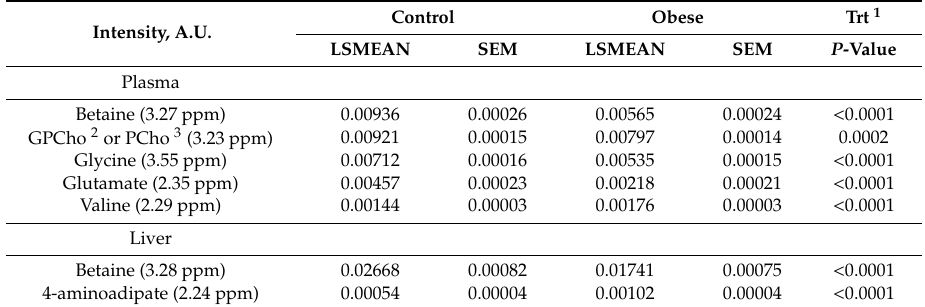
Table 1. E ff ects of diet-induced obesity on changes in the metabolomic profile of a swine model. Control Obese Trt 1 Intensity, A.U. LSMEAN SEM LSMEAN SEM P -Value Plasma Betaine (3.27 ppm) 0.00936 0.00026 0.00565 0.00024 < 0.0001 GPCho 2 or PCho 3 (3.23 ppm) 0.00921 0.00015